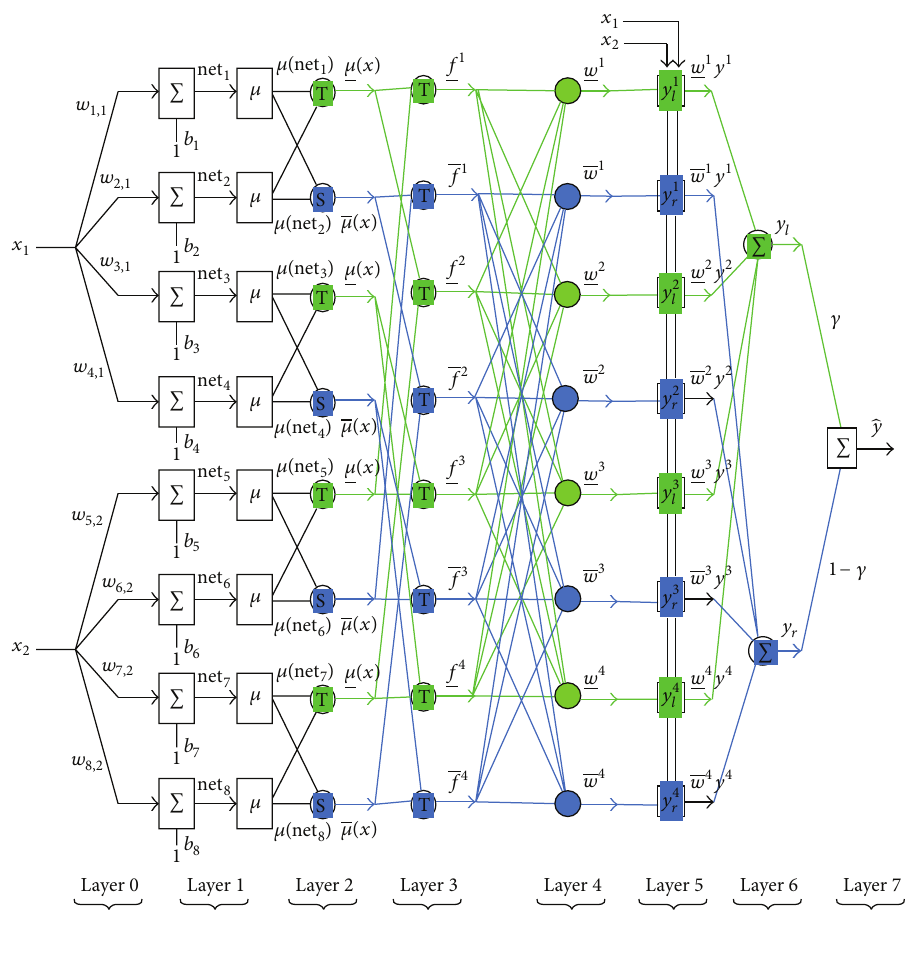
Figure 3: IT2FNN-0